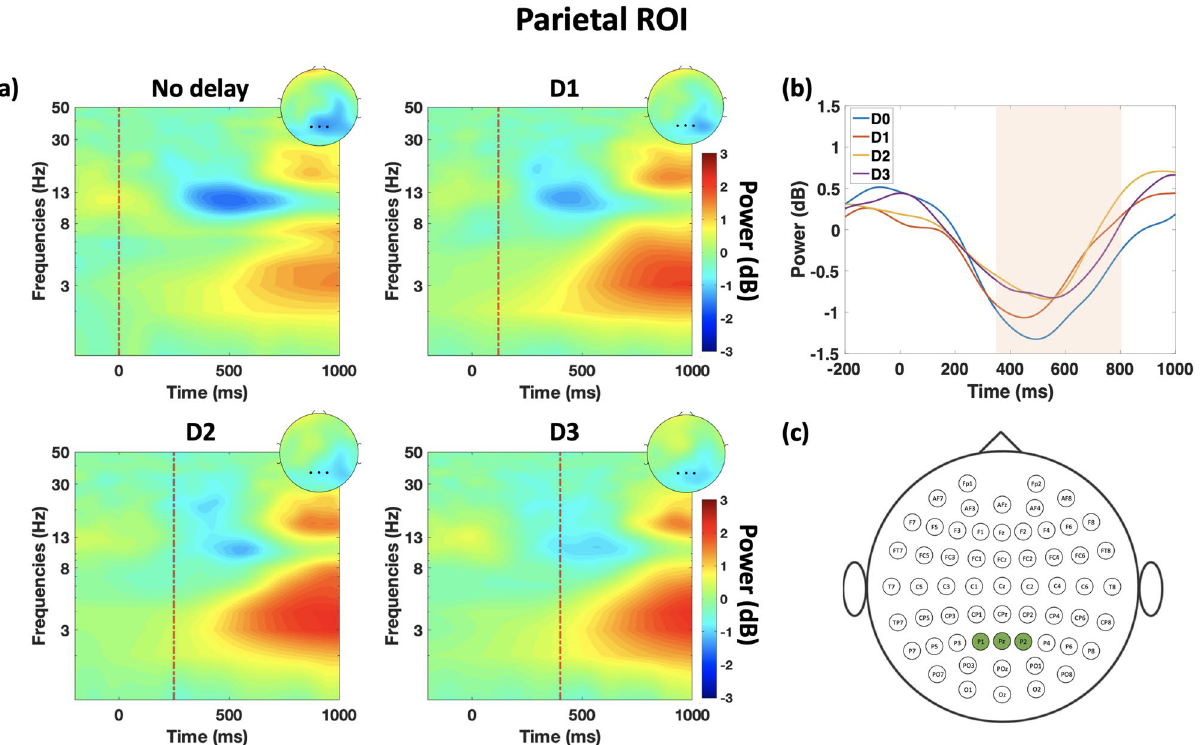
Figure 5. Time–frequency representation of alpha band correlates at the parietal ROI ( a ) ERSP dynamics of the EEG data in the parietal ROI averaged over trials and subjects per condition. The dashed red line shows the event of the haptic feedback disable. Topography plots are obtained by averaging power in the window of 300–700 ms where the maximal effect of alpha desynchronization is observed. ( b ) Time-course of the alpha power under the four delay conditions. Highlighted region signifies the time interval during which a statistically significant difference is found between the four conditions ( p ≤ 0.05, randomization-based ANOVA test, FDR corrected; t range = [340–800 ms]). ( c ) Channels included in the alpha band analysis at the parietal ROI.